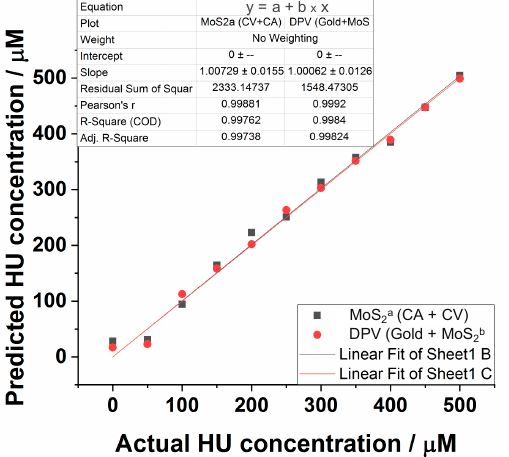
Figure 6. Predicted vs. actual HU concentration plot derived from multivariable linear regression models was calculated from the datasets CV + CA analysis with MoS 2a (black squares) and DPV analysis of gold + MoS 2b (red circles).